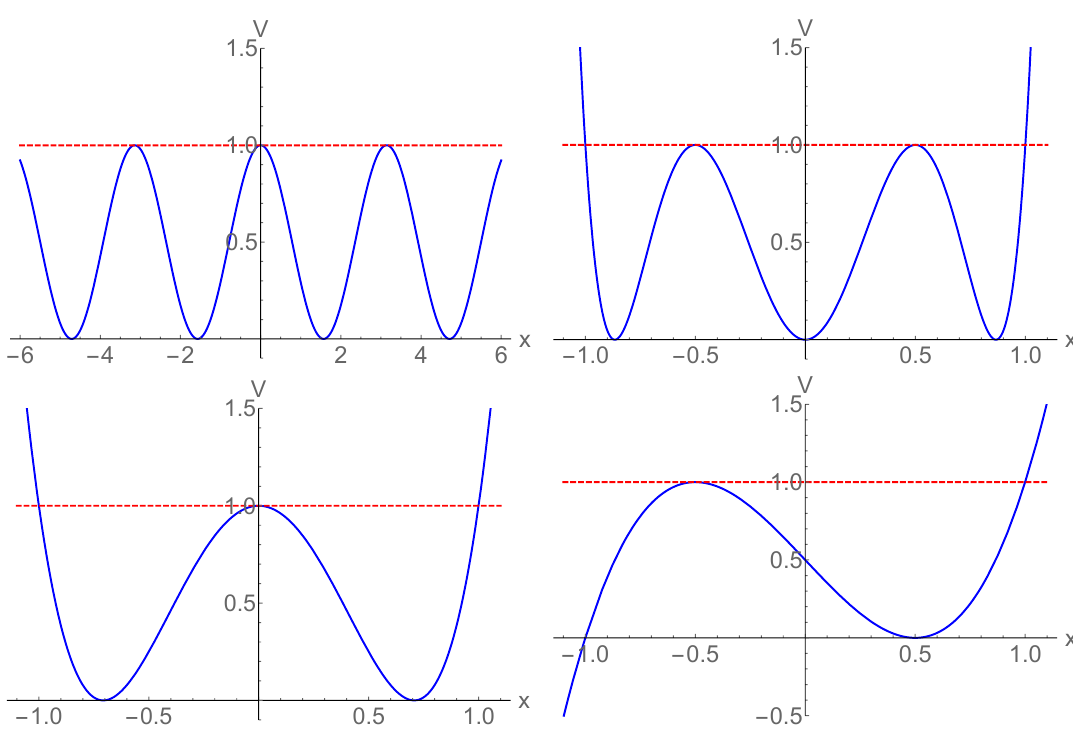
Figure 3 . Plots of the special class of Chebyshev potentials (respectively, Mathieu, symmetric degenerate triple well, symmetric double well, and cubic oscillator) whose classical actions and pe- riods are associated with Ramanujan’s theory of elliptic functions with respect to alternative bases, as featured in sections 3.2. At the quantum level, these are the potentials for which the quantum Matone and quantum Wronskian conditions take the special all-orders form in (1.5) and